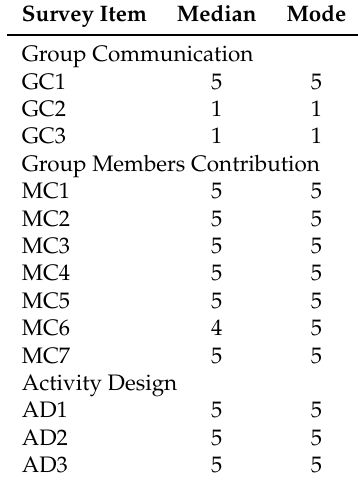
Table 3. Survey results of group communication, group members’ contribution, and activity